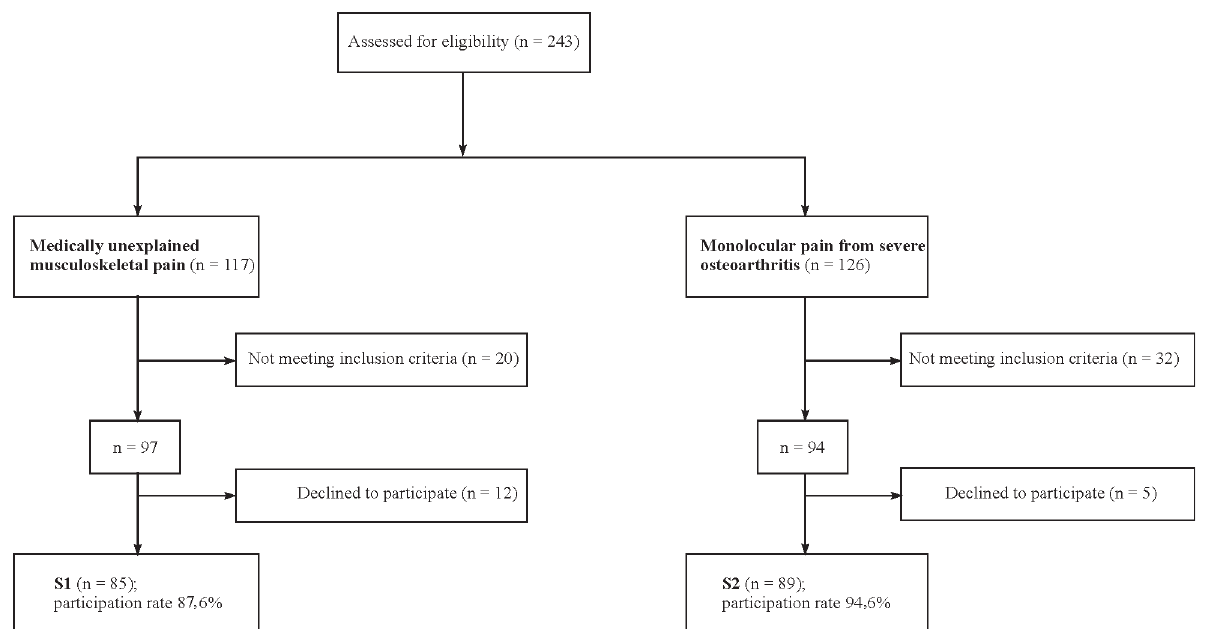
Fig 1. Flow chart of participant recruitment and